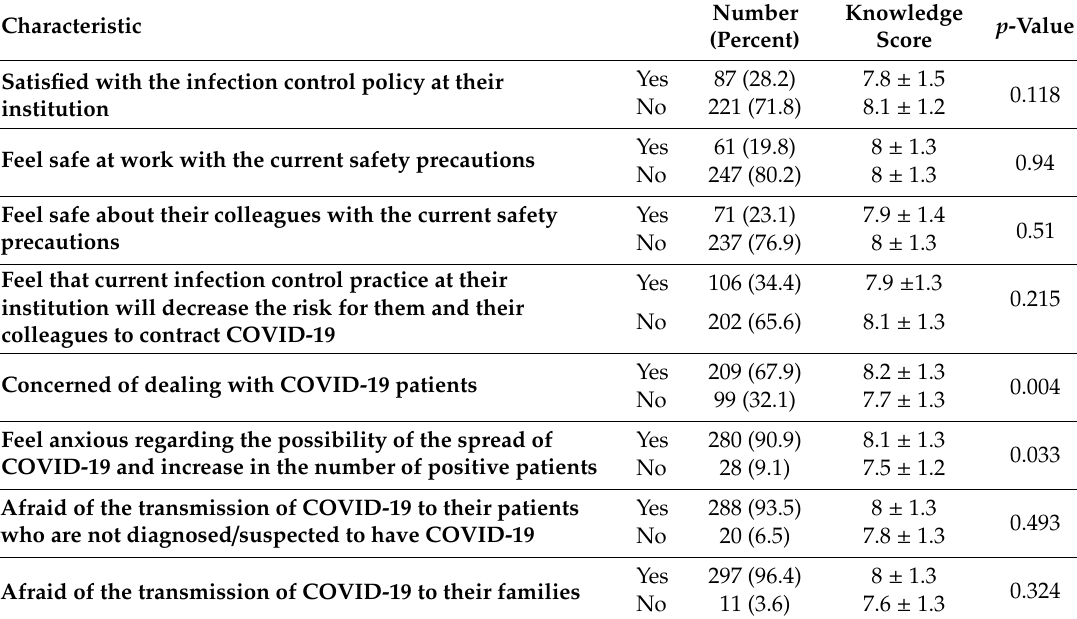
Table 4. The influence of knowledge about COVID-19 infection control practices on the psychological interactions and preparedness of frontline Jordanian